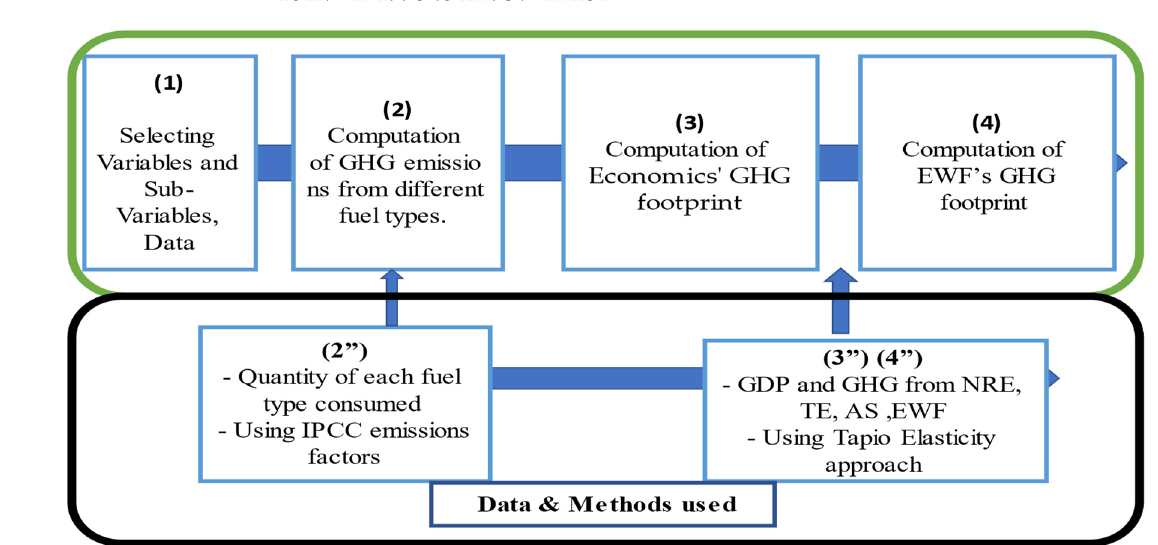
Figure 1. Diagram of research methodology.